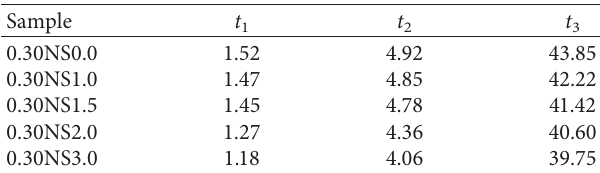
Figure 5: Effects of different dosages of NS on the hydration Table 5: The hydration period separation time of different NS content cement pastes (h).